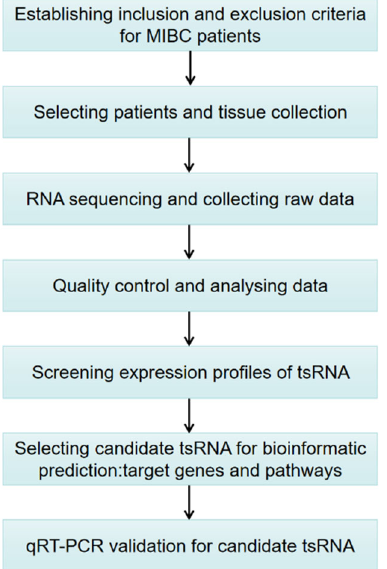
Figure 1. Study design illustration. MIBC, muscle-invasive bladder cancer; tsRNAs, tRNA-derived small RNA; qRT-PCR, quantitative real-time polymerase chain reaction.